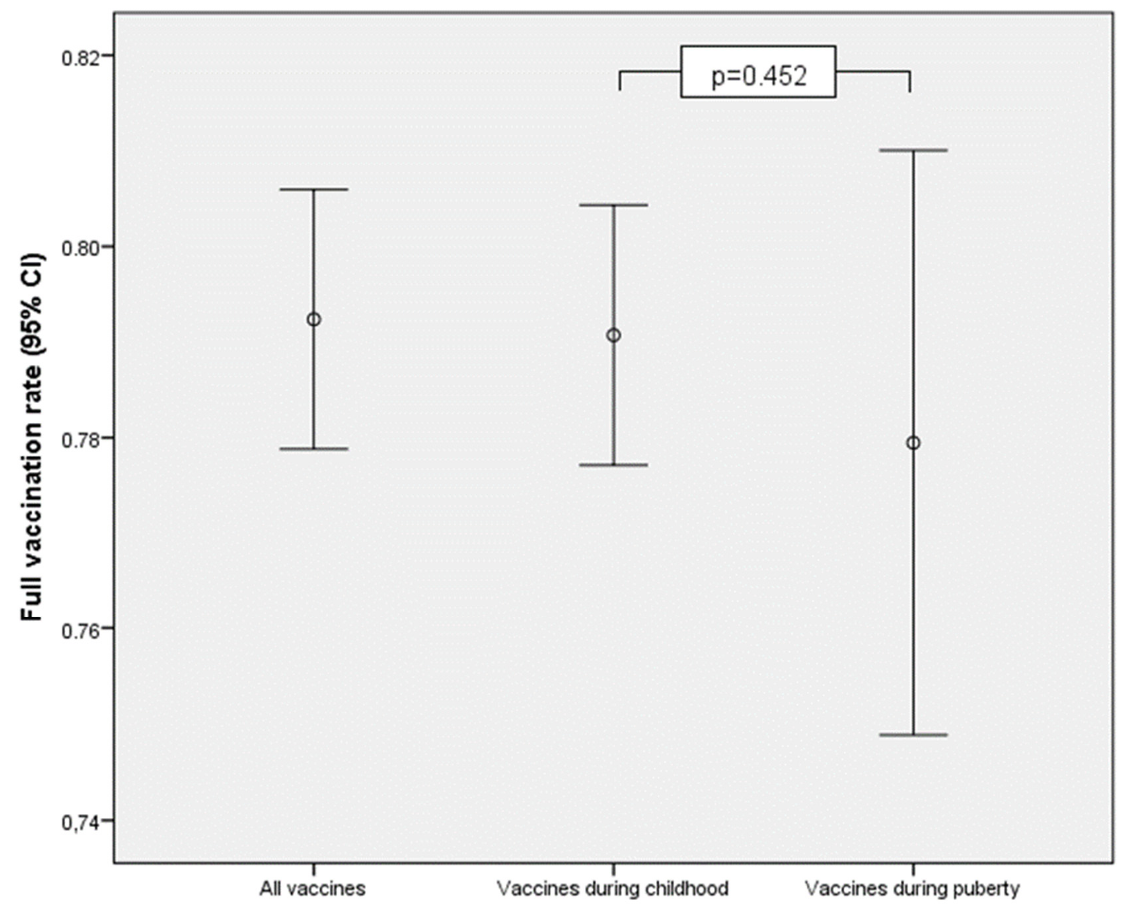
Figure 2. Full vaccination percentage in total and for vaccines that should be done during childhood and adolescence. The error bars represent percentage along with 95% Confidence Interval.